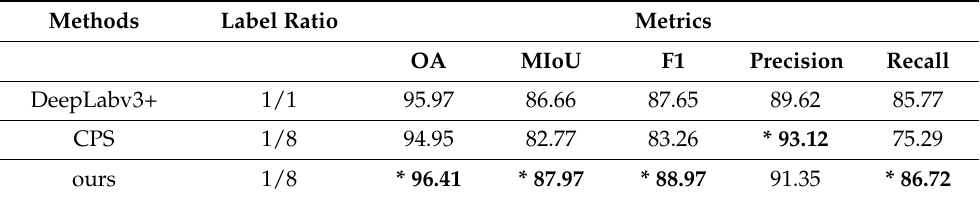
Table 4. Quantitative performance with early stop mechanism.